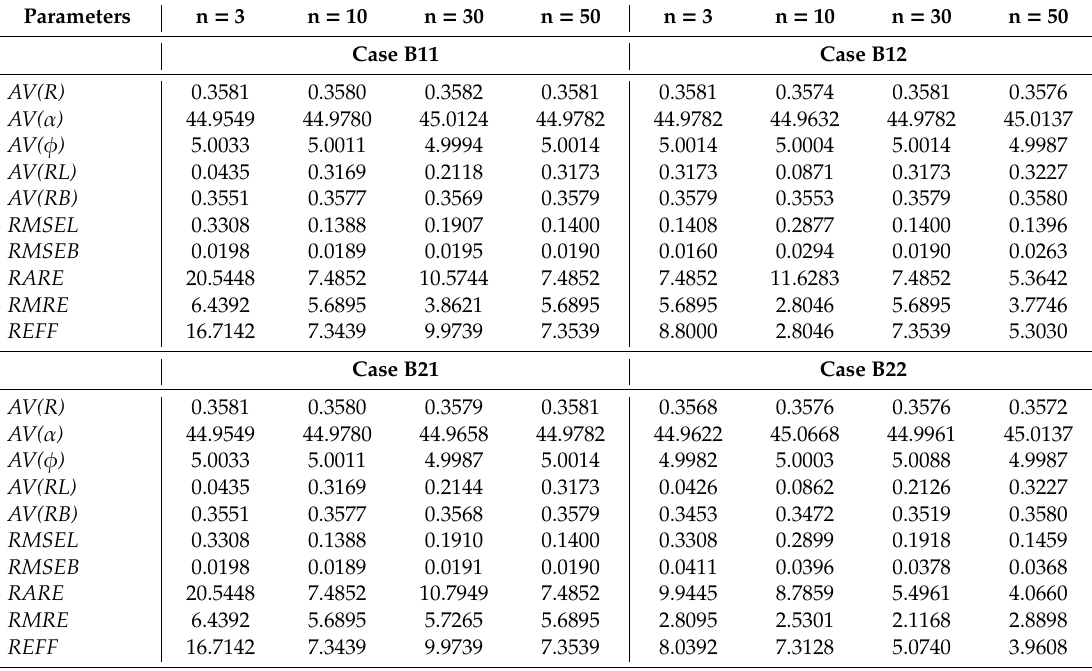
Table 4. Simulation results for cases Bij.